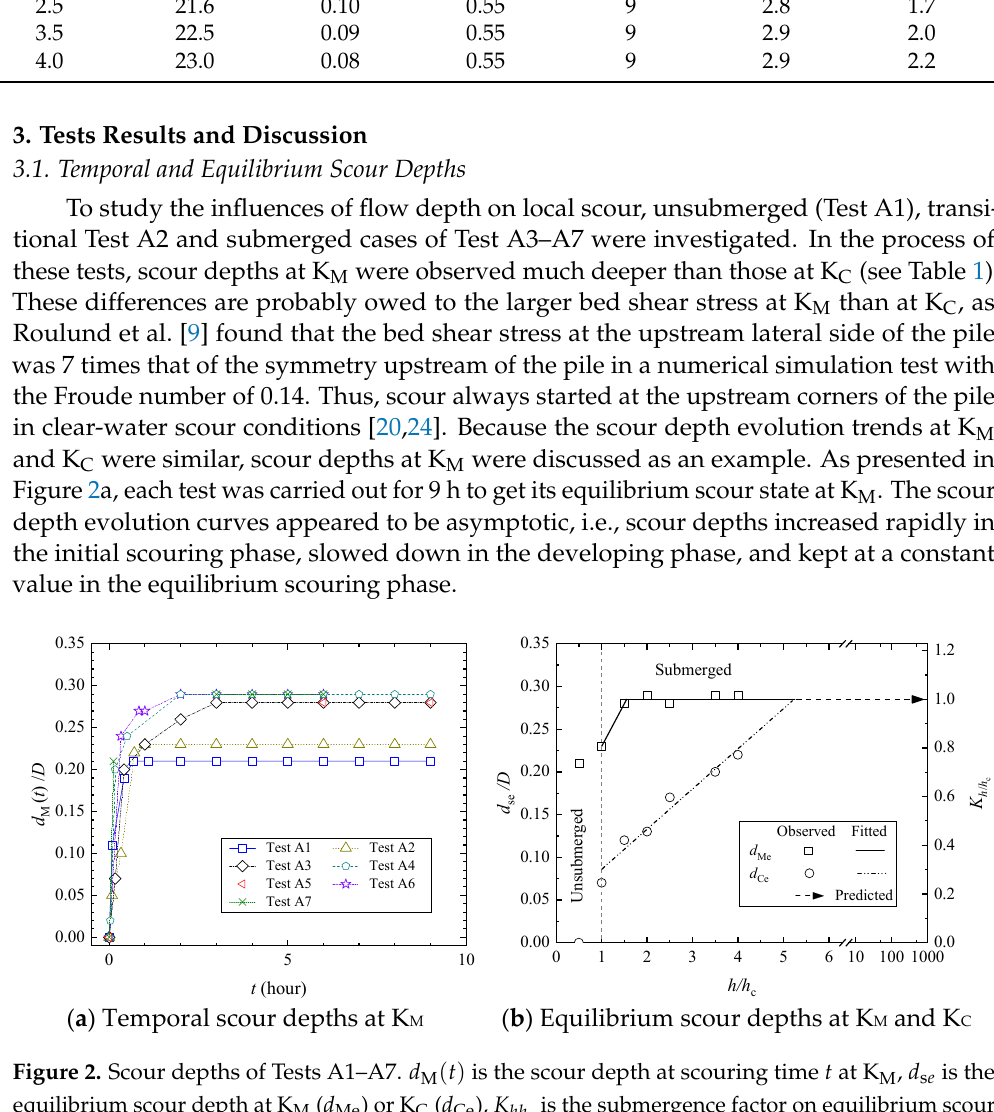
Figure 2. Scour depths of Tests A1–A7. equilibrium scour depth at K M ( d Me ) or K C ( d Ce ), K hh depths at K M